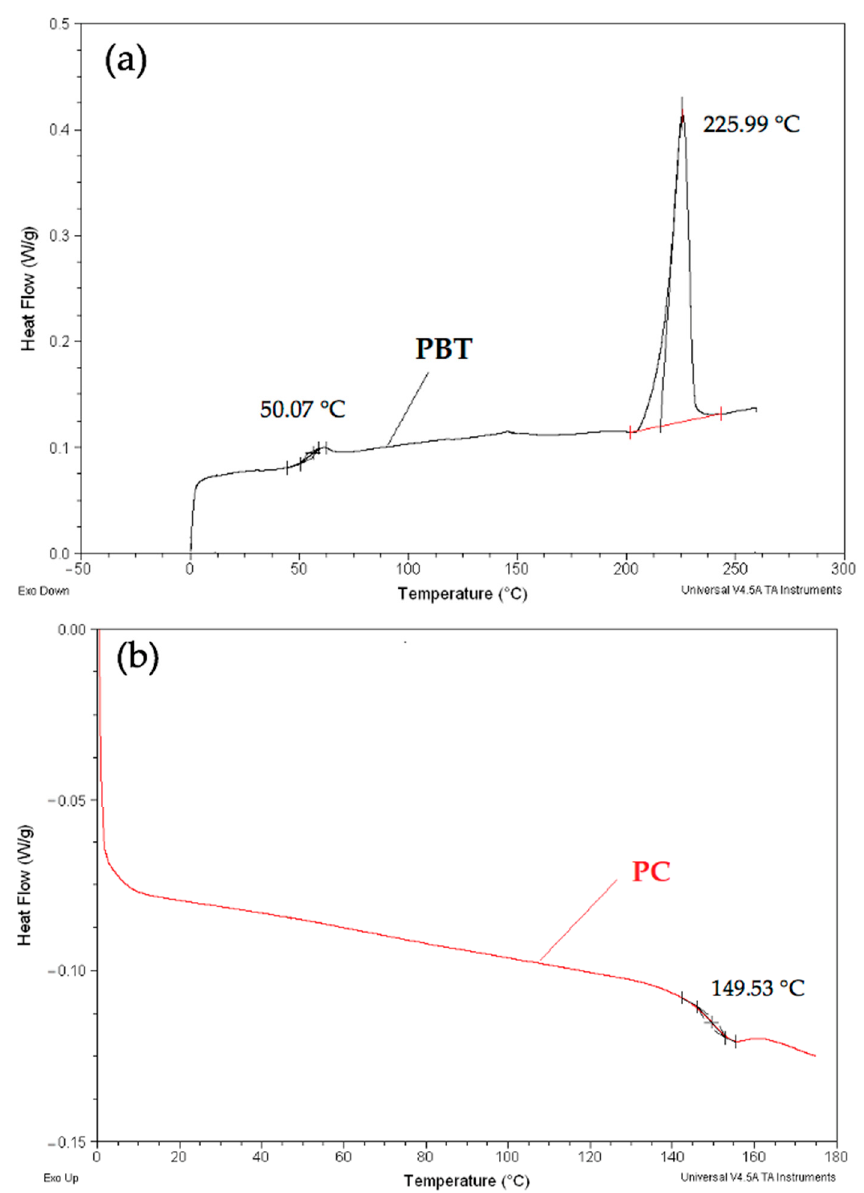
Figure 2. Thermograms of ( a ) PBT and ( b ) PC.